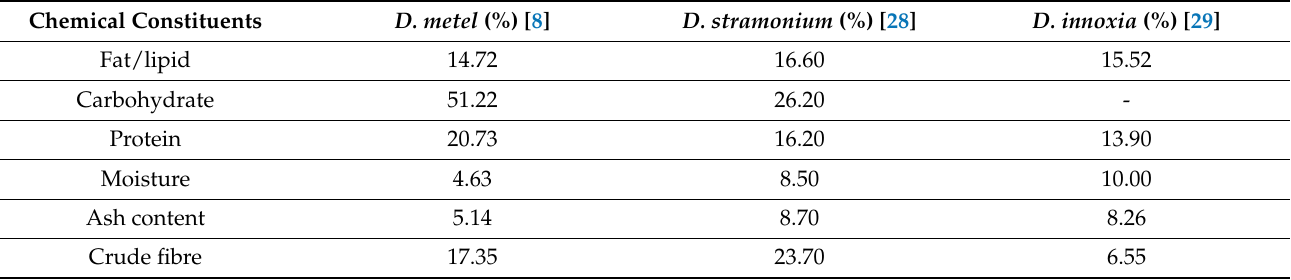
Table 1. Percentage composition of chemical compounds in the seeds of D. metel, D. stramonium , and D. innoxia. Chemical Constituents